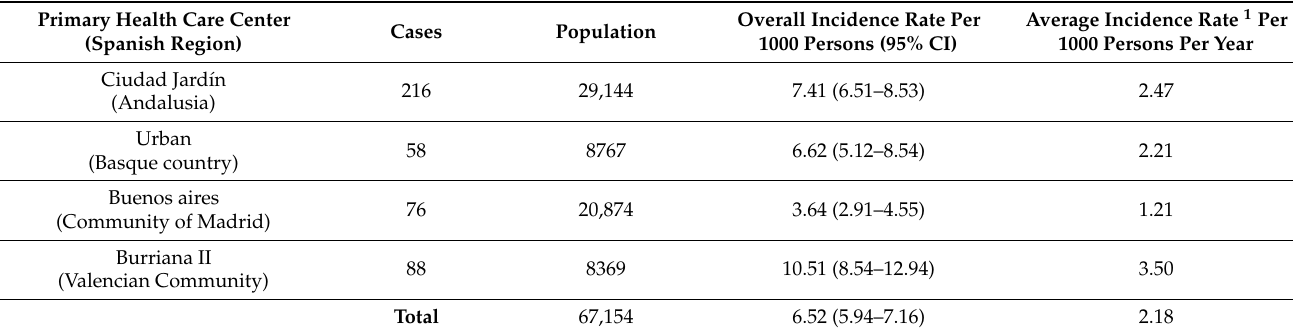
Table 1. Estimated incidence rates of community-acquired pneumonia (CAP) in four of the participating primary care